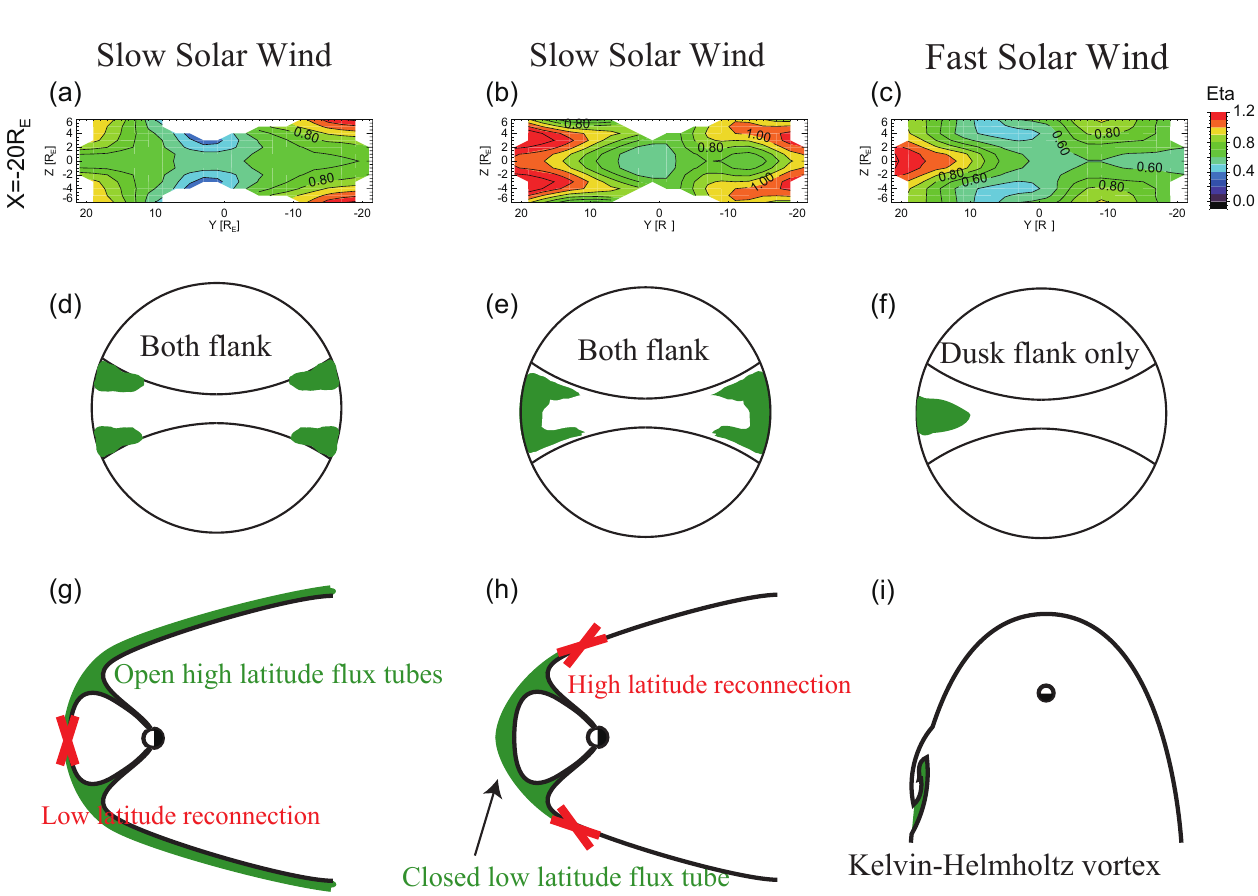
Fig. 13. Upper raw is cross-section view of plasma sheet from the tail side at X = − 20 R E . Middle raw is schematic picture for upper